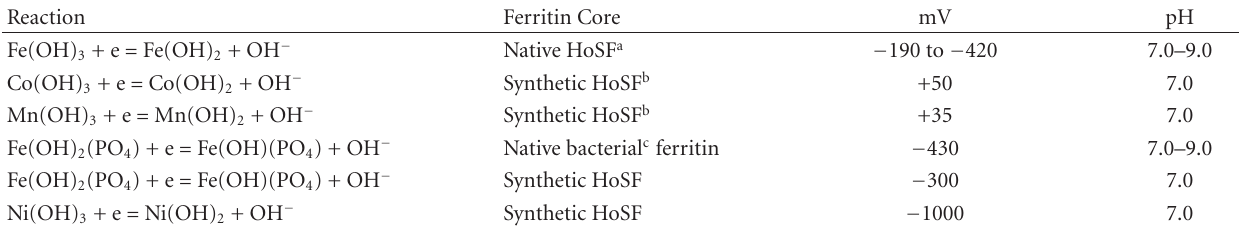
Table 1: Electrochemical properties of ferritins with di ff erent core minerals.